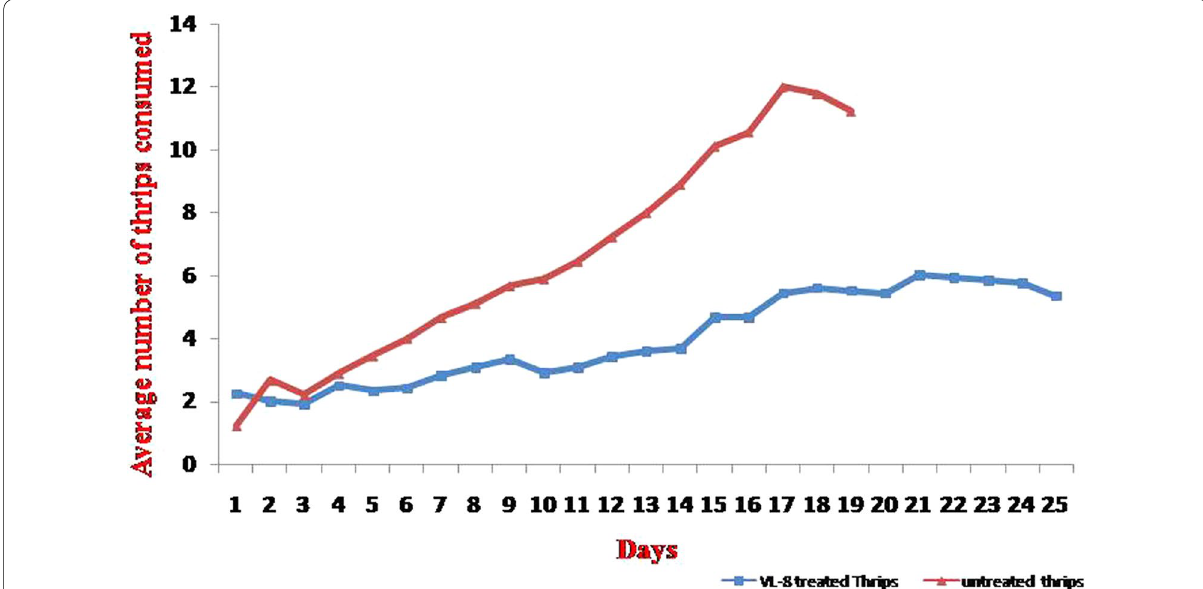
Fig. 1 Feeding potential of different instars of Blaptostethus pallescens fed on Lecanicillium lecanii (Vl-8) treated and untreated Frankliniella